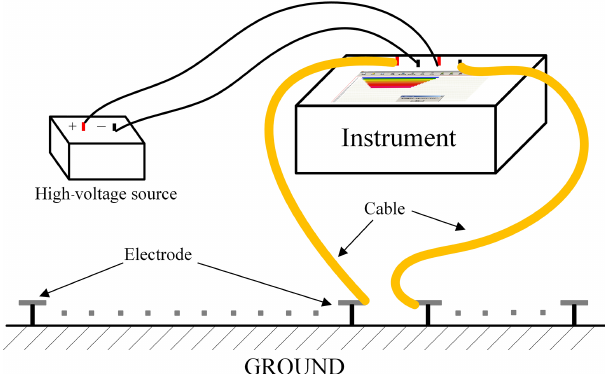
Figure 2. Principle of the high-density electrical